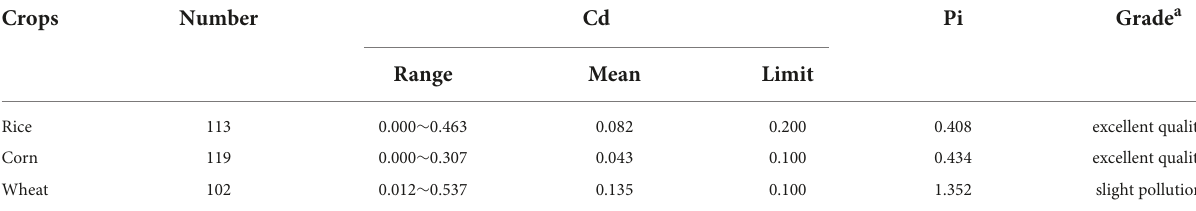
TABLE 2 The single factor pollution index of Cd in rice, corn, and wheat grains